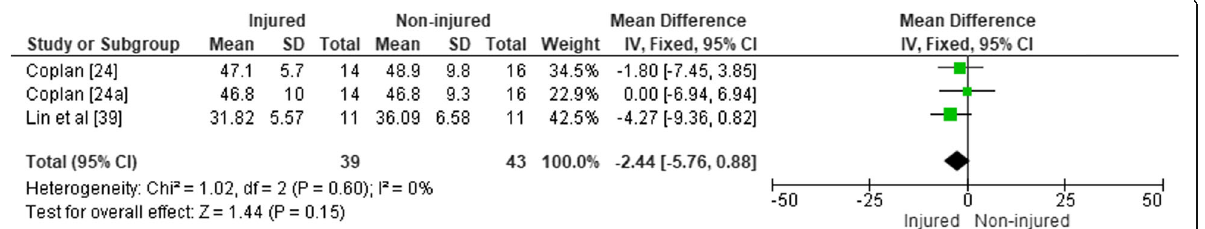
Fig. 2 Forest plot of the comparison of hip external rotation between injured and non-injured dancers. Note: Coplan is reported twice as the author measured both right [24] and left [24a]